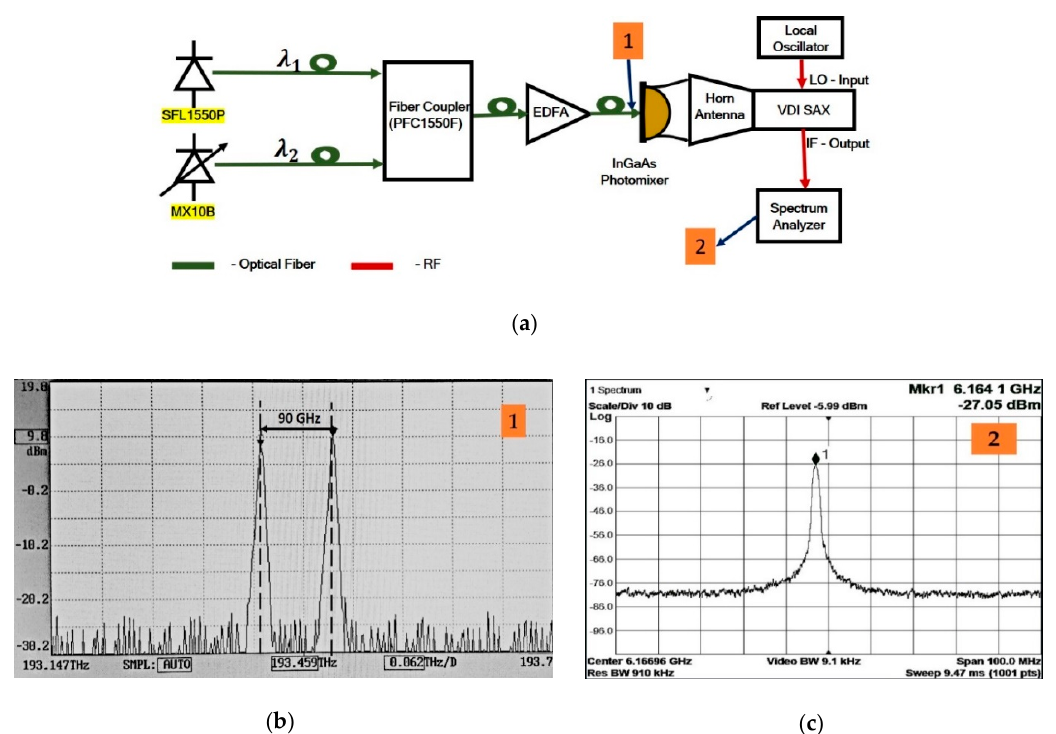
Figure 2. Photomixer evaluation test set-up. ( a ) A schematic diagram of the test set-up with the optical link and receiver channels. ( b ) Two optical signals at the photomixer input with 90 GHz frequency difference. ( c ) Downconverted infrared (IF) signal measured by Keysight Spectrum Analyzer (KSA).